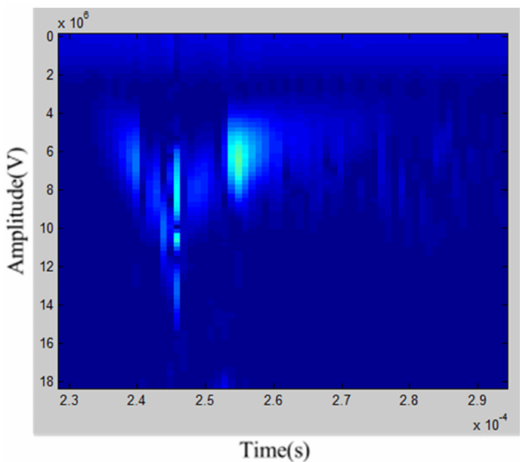
Figure 5. Results of applying Equation (4) to the images resulting from the STFT from test specimens without and with defects.